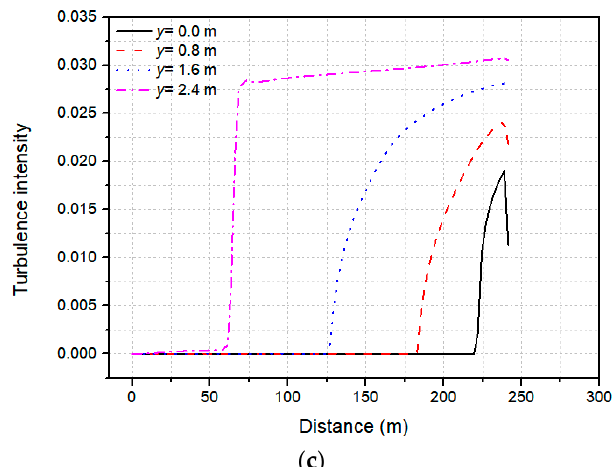
Figure 11. Propagation of turbulence intensity variation on high-pressure and high-speed conditions. ( a ) Data Extraction line ( y = 0, 0.8, 1.6, 2.4 m), ( b ) turbulence intensity contour in front of the pod, and ( c ) turbulence intensity for 1013.25 Pa and 350 m/s.